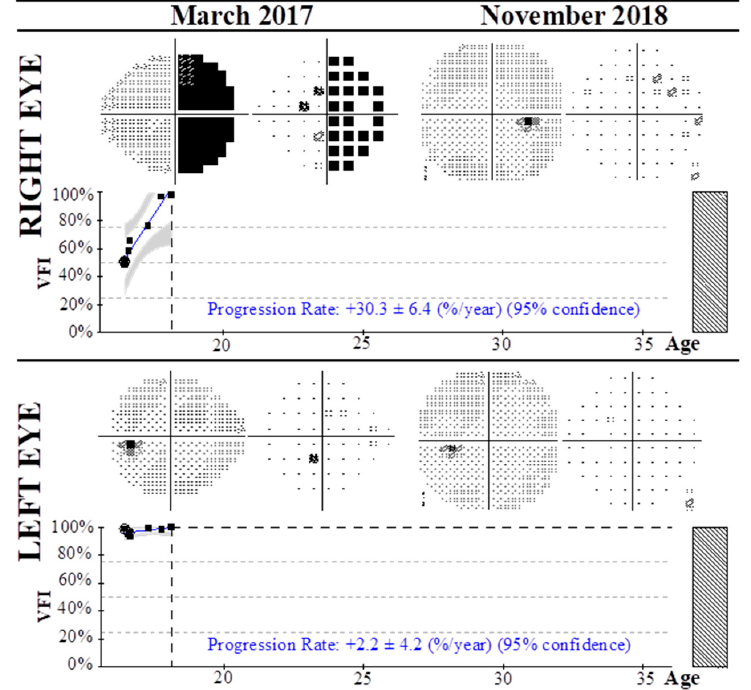
Figure 2. Visual field test using the Humphrey field analyzer and 30-2 algorithm of a case of right hemianopia of unknown origin (Stroke 04) from March 2017 to November 2018. After four months of the acute event the patient was treated with CoQ10 and vitamins to date, with progressive improvement of the visual field index in the affected right eye. Progression rates at 95% confidence level are shown. Table 4. Clinical characteristics of RAO patients, VFI and MD follow-up, and progression